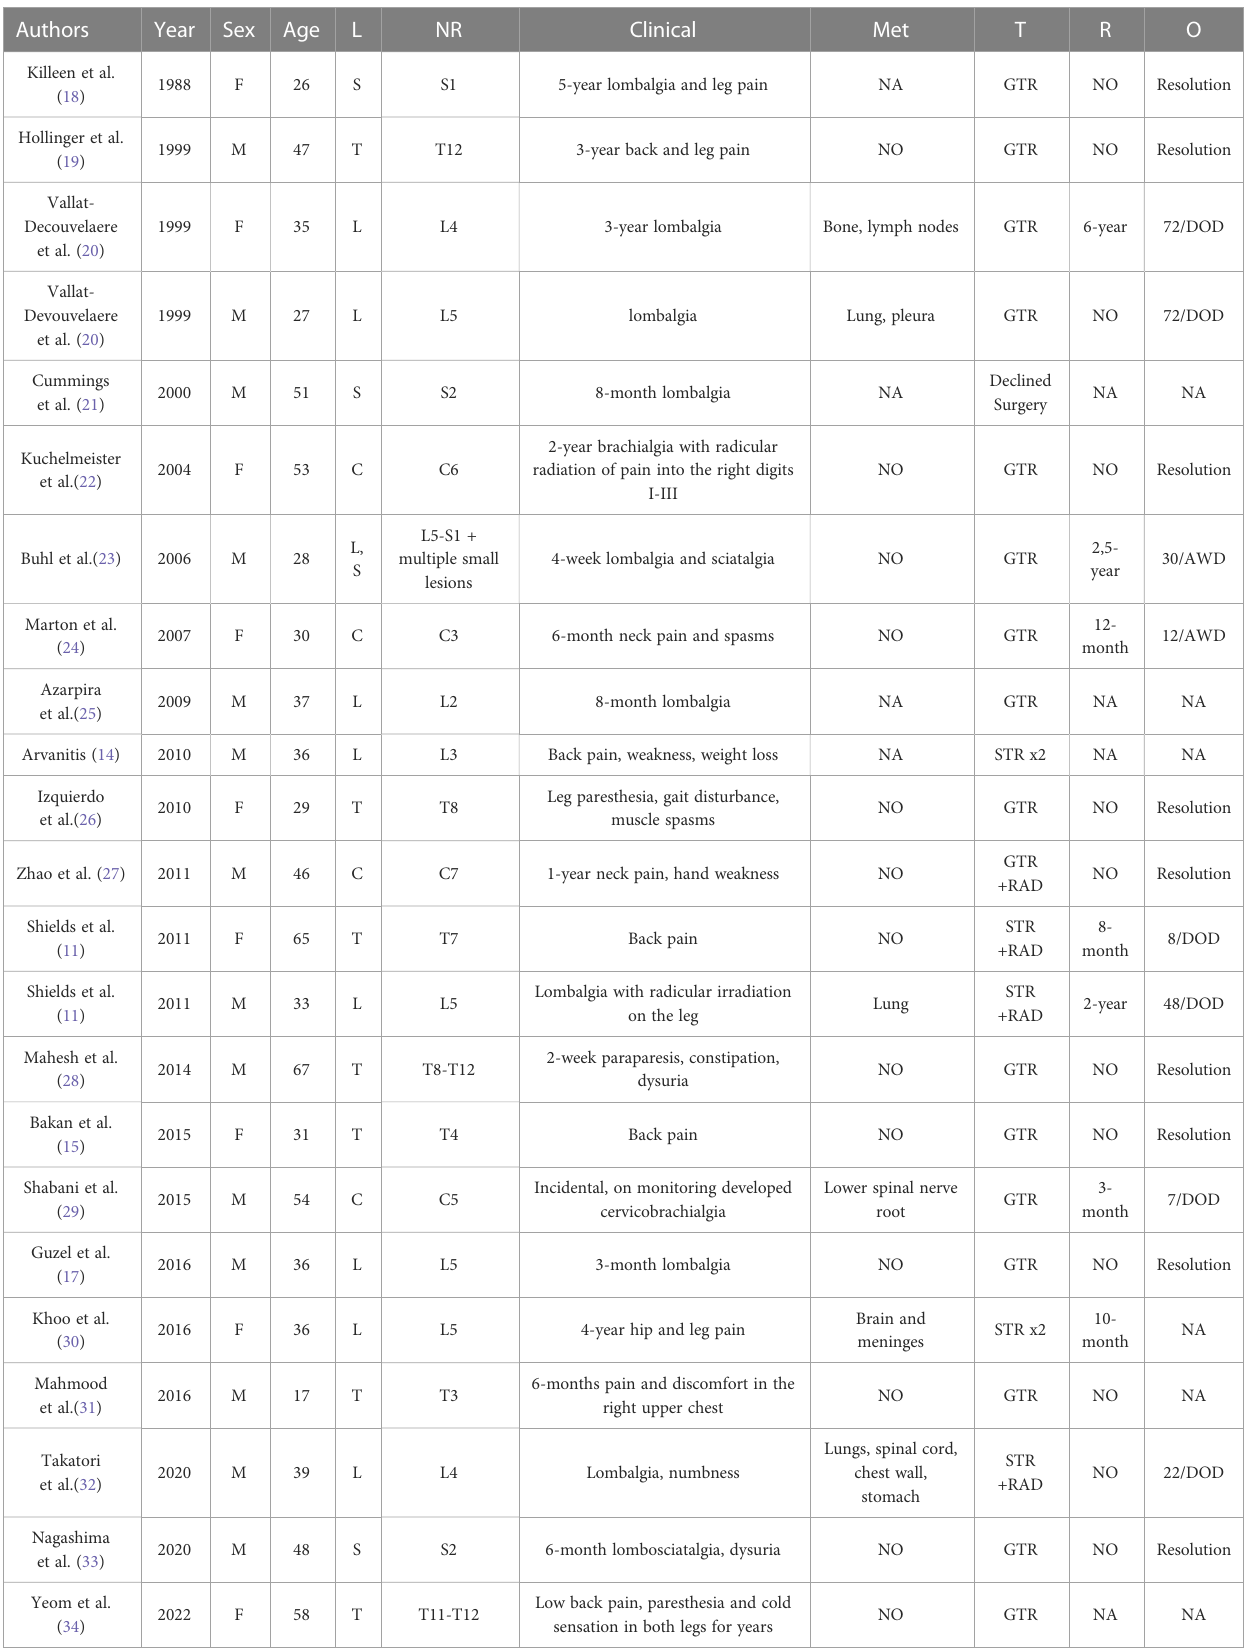
TABLE 1 Reported cases of sporadic spinal psammomatous melanotic